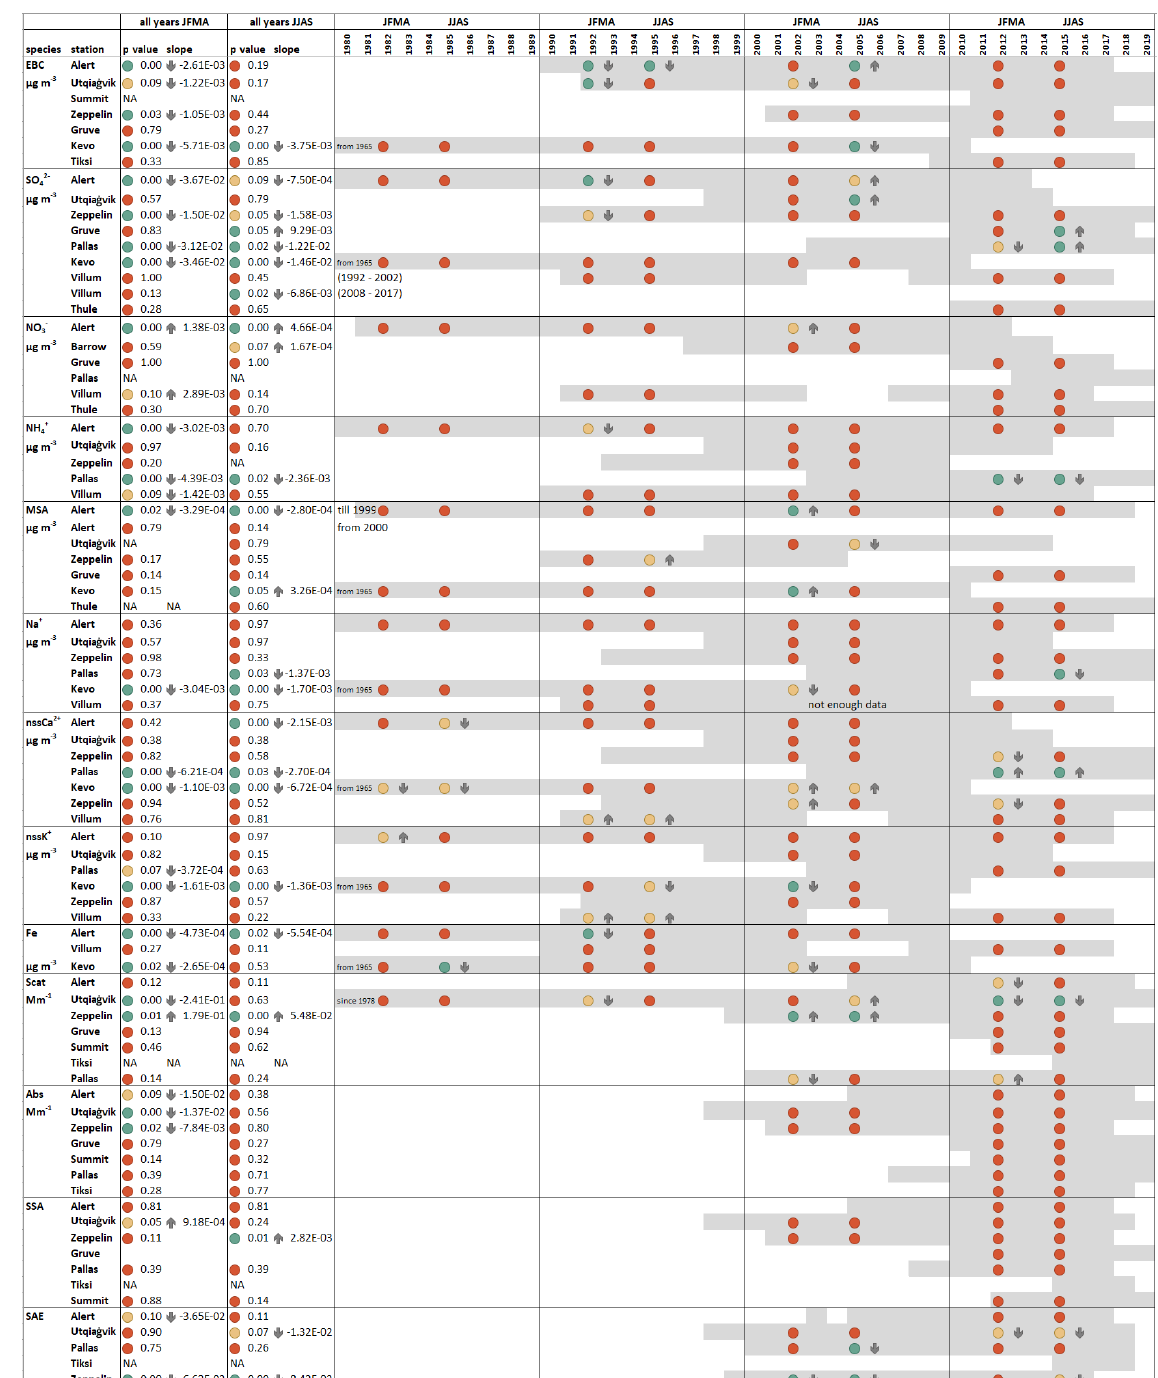
Table 3. Data coverage and trends. The grey bars on the right side indicate data availability per station and variable. The p values and slopes on the left side indicate the overall trends characteristics per station and variables separated by season (JFMA and JJAS). Round markers indicate the significance of the trend, where green corresponds to a p value < 0 . 05, orange to 0 . 05 <p value < 0 . 10, and red p value > 0 . 10. The arrows indicate whether the trend is positive or negative. Decadal trend significance and direction are given by markers only in the respective time period. The two left (right) symbols correspond to JFMA (JJAS). Chemical compounds were derived from the following size ranges (see also Table 1): TSP for Alert and Villum, PM 10 for Zeppelin, and PM 1 for Barrow/Utqia˙gvik. NA means there are not enough values above detection limit to calculate a p